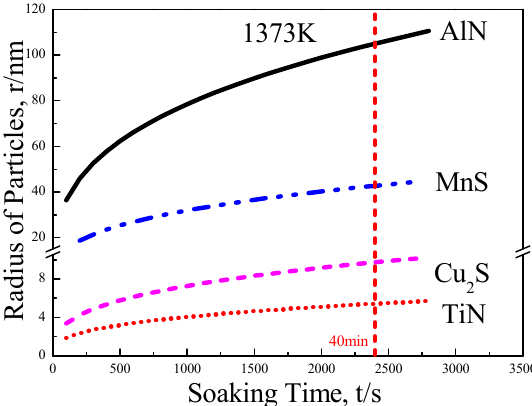
Figure 11. The growth potential of Cu 2 S, TiN, AlN, and MnS in γ -Fe at 1373 K.